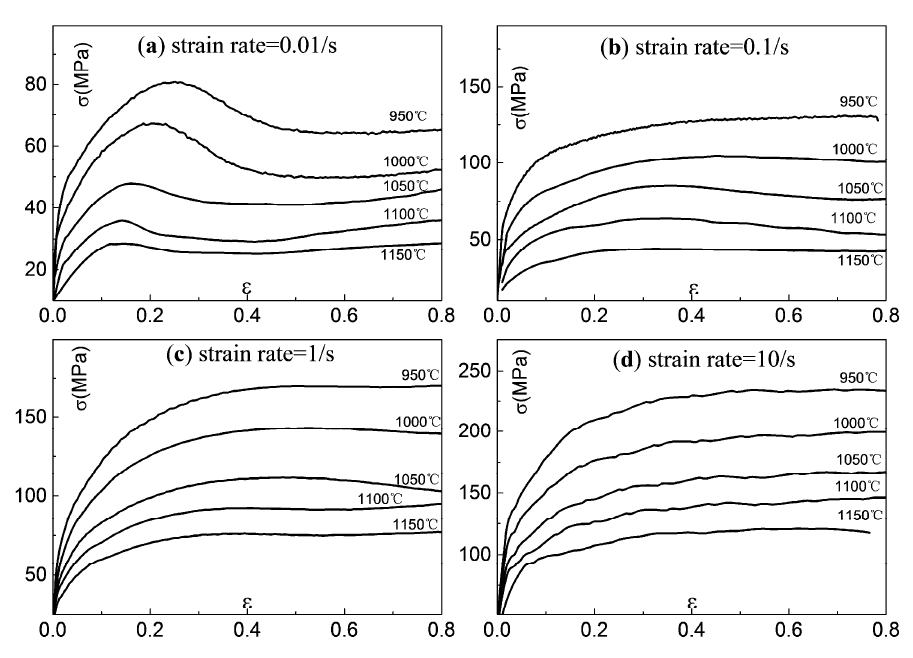
Figure 2. Stress-strain relationships of 300M steel compressed at different temperatures and strain rates: ( a ) 0.01 s − 1 , ( b ) 0.1 s − 1 , ( c ) 1 s − 1 , and ( d ) 10 s − 1 .